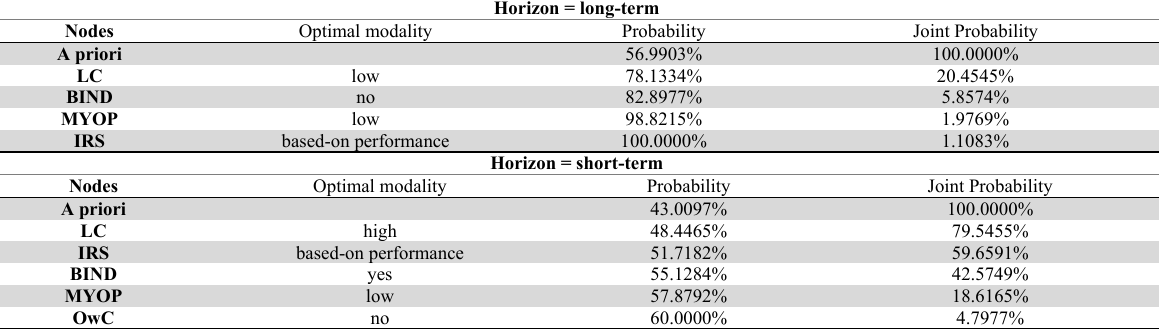
Target dynamic profile